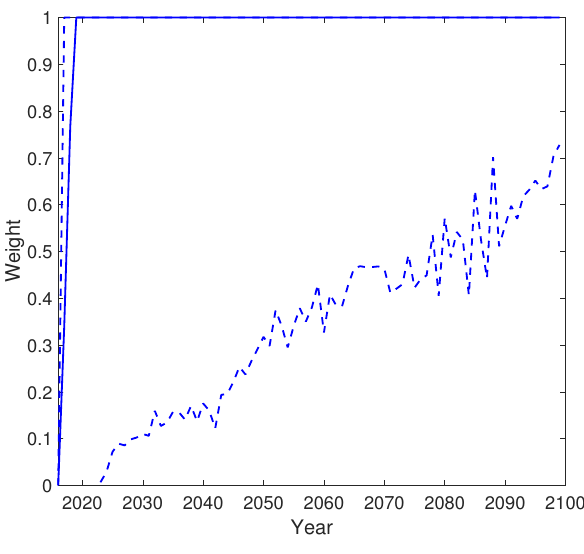
Figure A1. The 2.5%, 50%, and 97.5% quantile of the weight over time for China. As for Brazil, Figure A2 shows that the median rotation completion time is 2029. Moreover, it is completed by 2040 in 97.5% of the simulated scenarios, and before 2020 in 2.5% of the scenarios. The 95% confidence bound of w s for Brazil is narrower than that of China, indicating that Brazil’s historical mortality experience is less volatile.